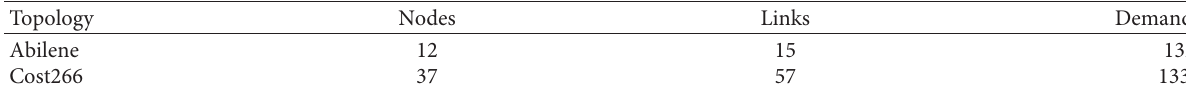
Figure 7: The cumulative distribution function curve of the integrated latency. Table 5: Topologies in the experiment.